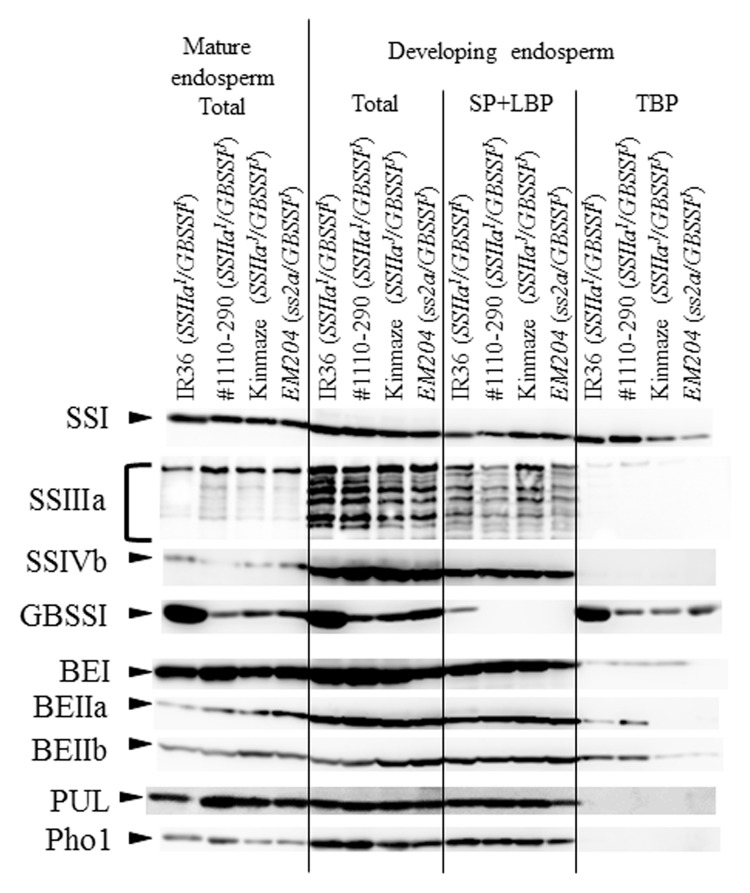
Isozyme distribution in protein fractions [Total protein (Total), soluble protein (SP), loosely bound protein (LBP), and tightly bound protein (TBP)] extracted from developing endosperm (10–15 DAF). Immunoblotting of each fraction was performed using anti-SSI, SSIIa, SSIIIa, SSIVb, GBSSI, BEI, BEIIa, and BEIIb antibodies. IR36, indica rice cultivar, SSIIaI/GBSSII; #1110-290, SSIIaI/GBSSIJ; Kinmaze, japonica rice cultivar, SSIIaJ/GBSSIJ; EM204, ss2a/GBSSIJ.